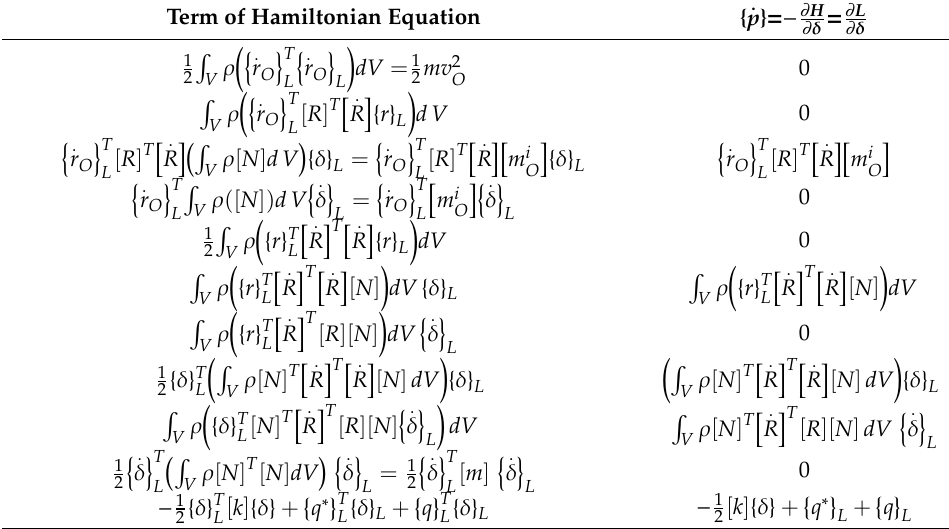
Table 1. The derivatives of Hamiltonian equations. Term of Hamiltonian